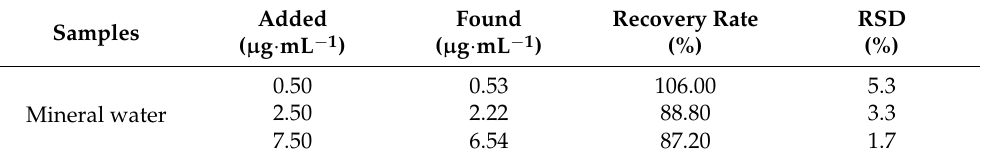
Table 2. Standard recovery of laundry detergents from different water samples ( n =